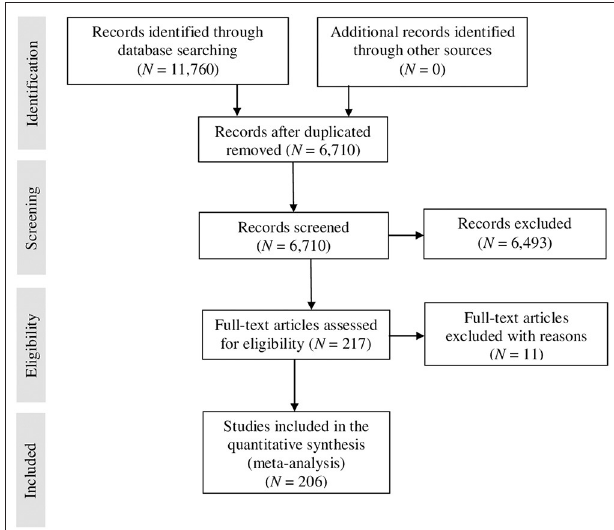
FIGURE 1 | PRISMA flow diagram of the included and excluded